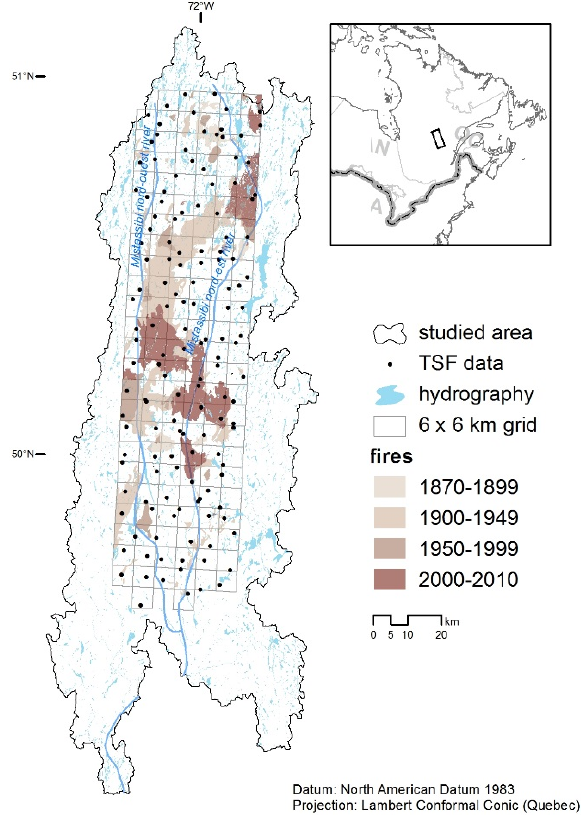
Figure 1. Stand origin map [21] within the study area, including fire delineation (1900–2010) from aerial photos and time elapsed since last fire (TSF) sampling points.